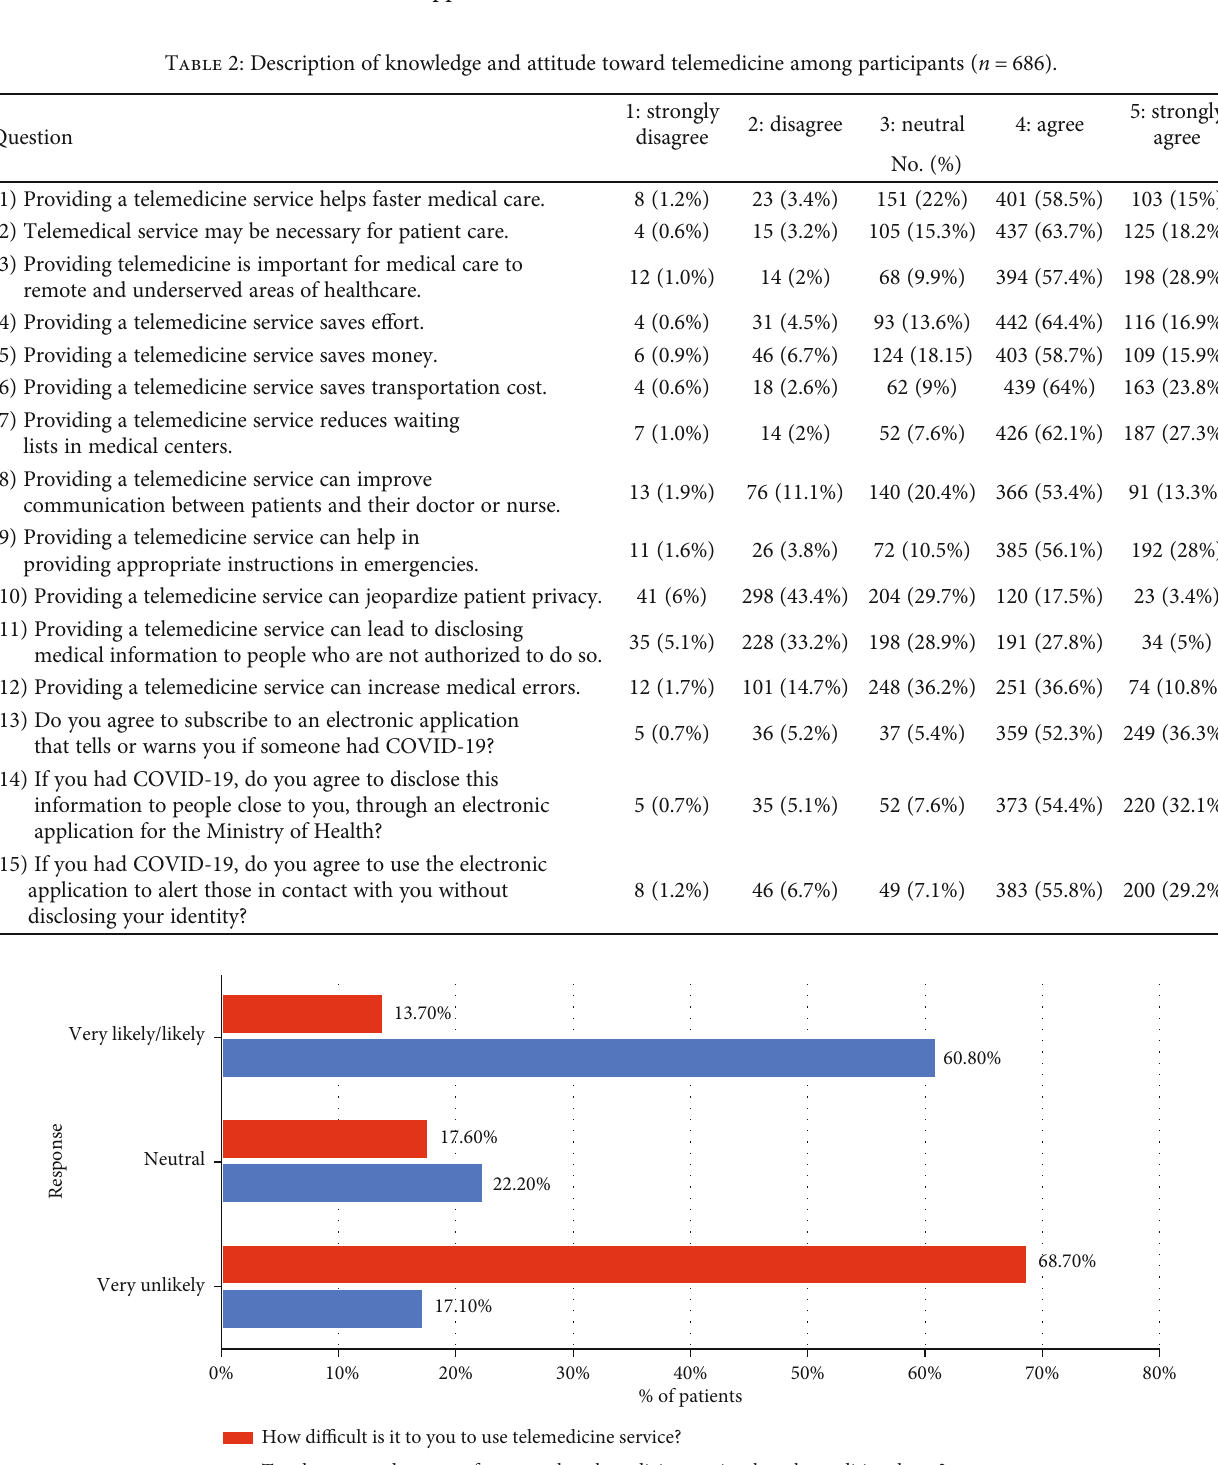
Figure 1: The overall perception towards